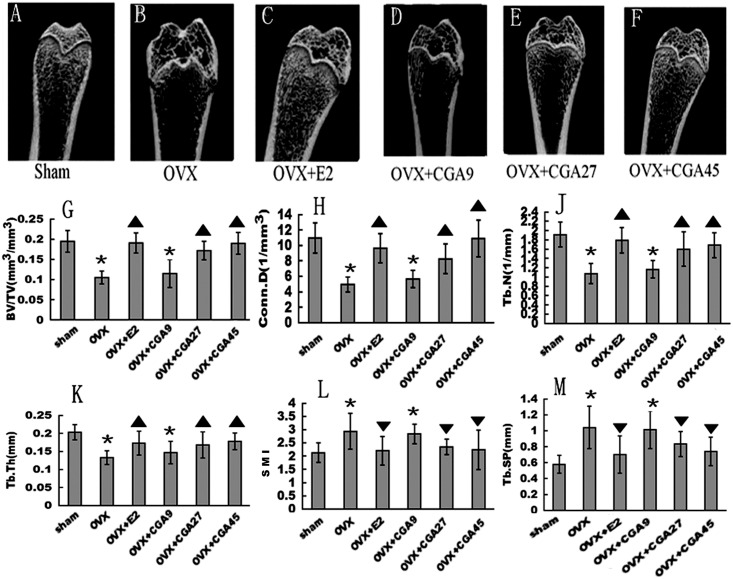
Positive effects of E2 and CGA on parameters of bone microarchitecture in OVX rats.*p < 0.01 vs. sham group. (A–F) μCT images showing representative trabecular bone microarchitecture of the femoral metaphysis for each treatment group. (G–K) Effects of E2 and CGA on BV/TV, Conn.D, Tb.N, and Tb.Th in OVX rats. ▲ increase vs. OVX group (p < 0.05). (L and M) Effects of E2 and CGA on SMI and Tb.Sp in OVX rats. ▼decrease vs. OVX group (p < 0.05).